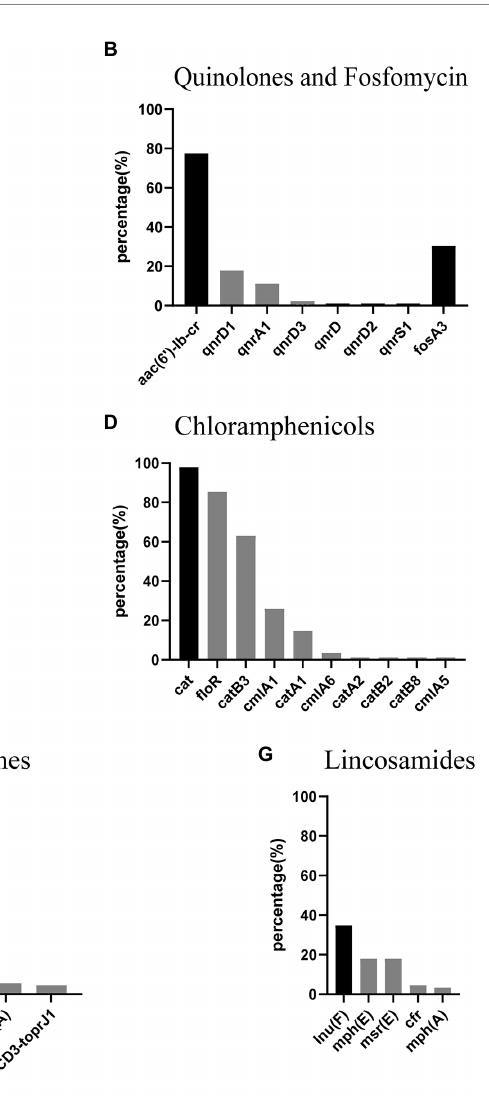
FIGURE 2 Percentage of antimicrobial resistance genes in P.mirabilis strains from food markets. (A-G) the most prevalent resistance genes for each class of antimicrobials are in deep black. Note: cfr is a multiresistance gene conferring resistance to lincosamides, phenicols, oxazolidinones, pleuromutilins, and streptogramin